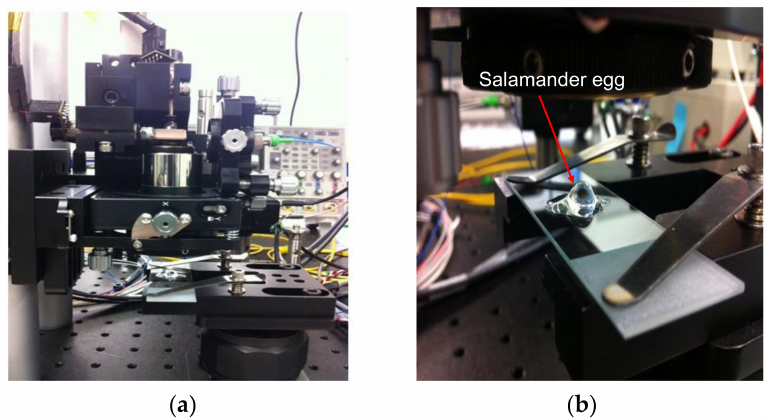
Figure 3. ( a ) Our experimental SS-OCT; ( b ) Axolotl salamander egg at the sample